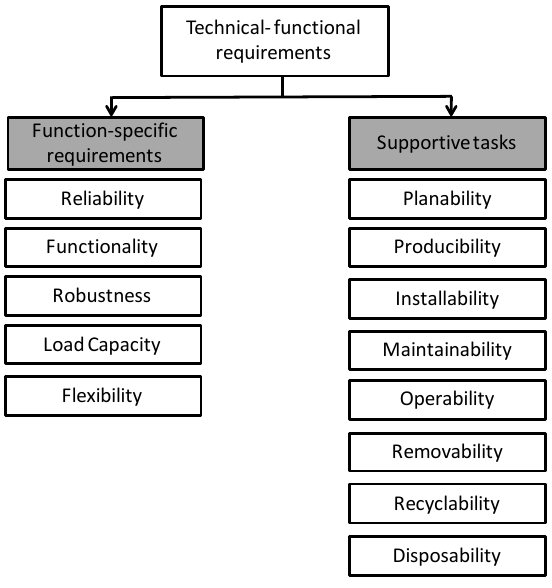
Figure 4. Structuring in line with the dimension “technical-functional